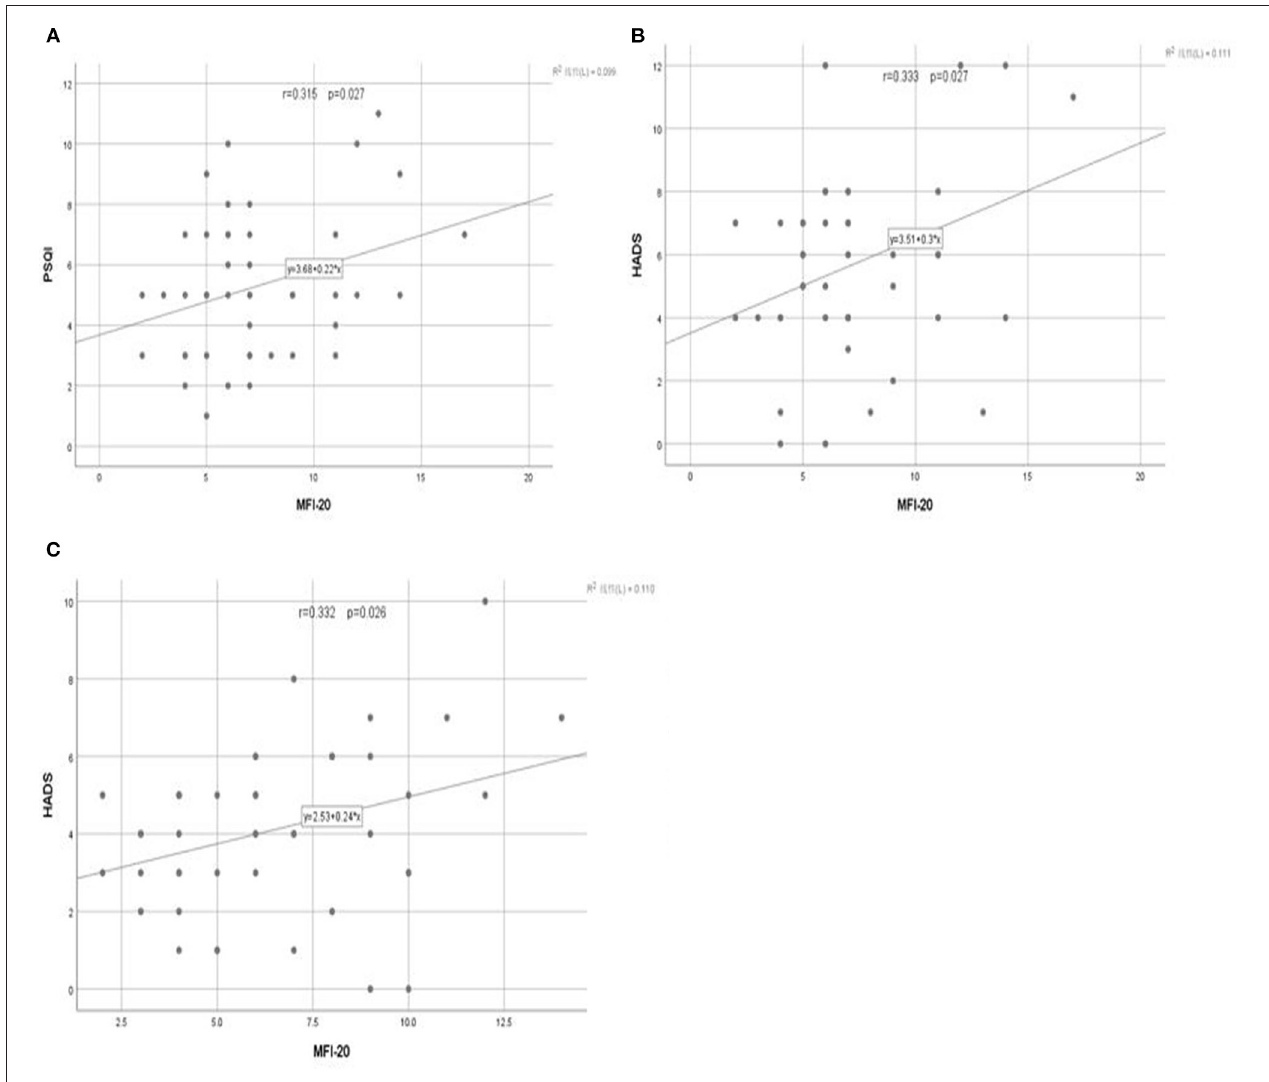
FIGURE 3 | The linear relationship between the total score of fatigue and the total score of sleep and anxiety at the end of treatment. The relationship between the (A) total score of fatigue and the total score of sleep after PLWNT exercise. (B) total score of fatigue and the total score of anxiety after PLWNT exercise. (C) total score of fatigue and the total score of anxiety after CBT